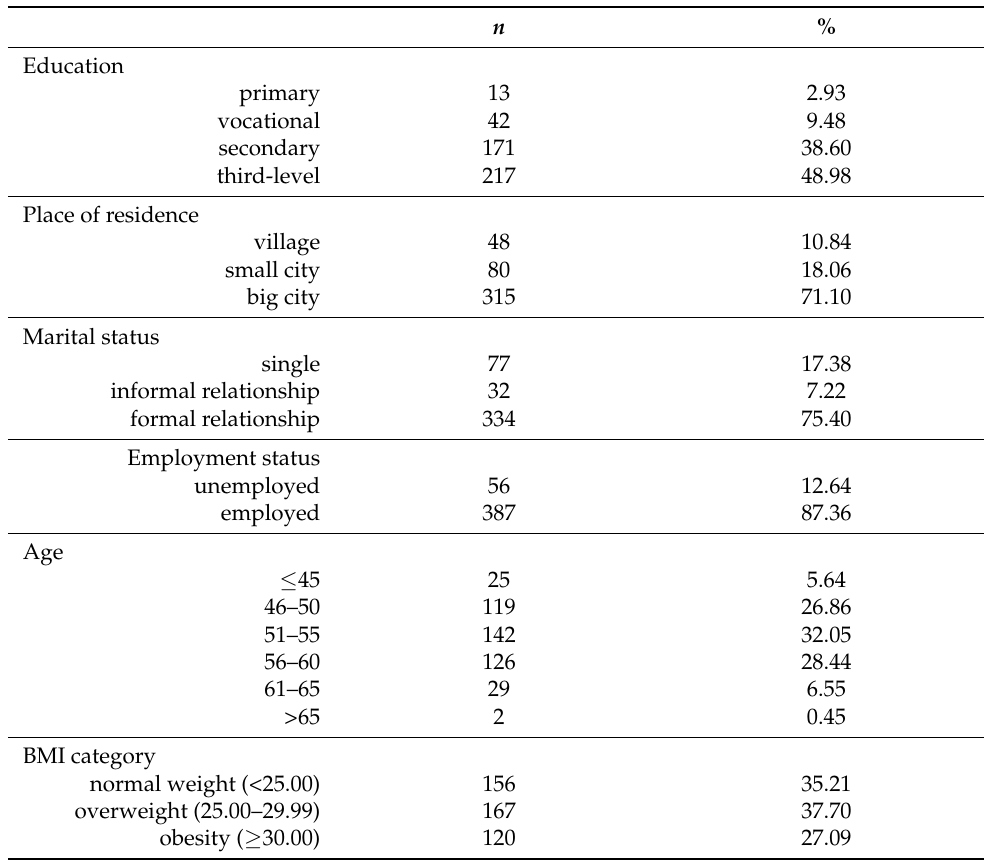
Table 1. Characteristics of the study sample ( N = 443).